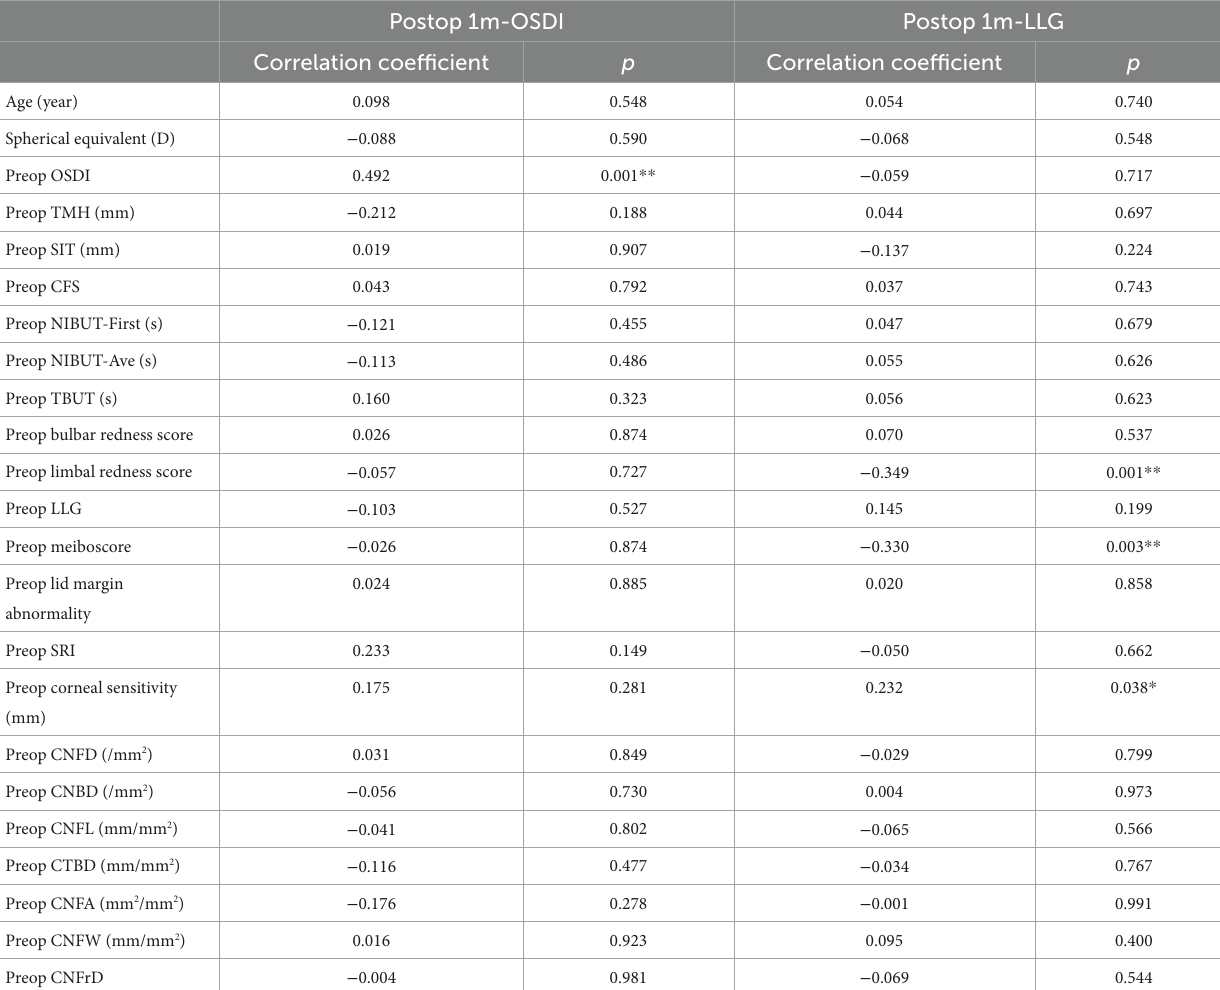
TABLE 2 Correlation coefficients between preoperative parameters and OSDI and LLG at postoperative 1 month in all patients. Postop 1 m-OSDI